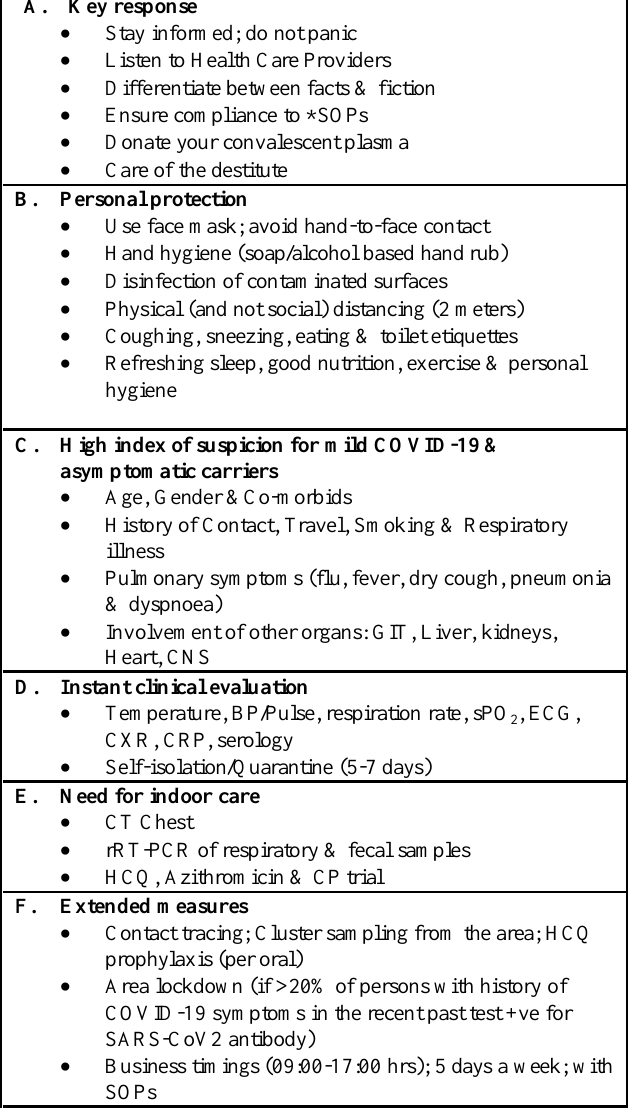
Table 3. Algorithm for management of COVID-19